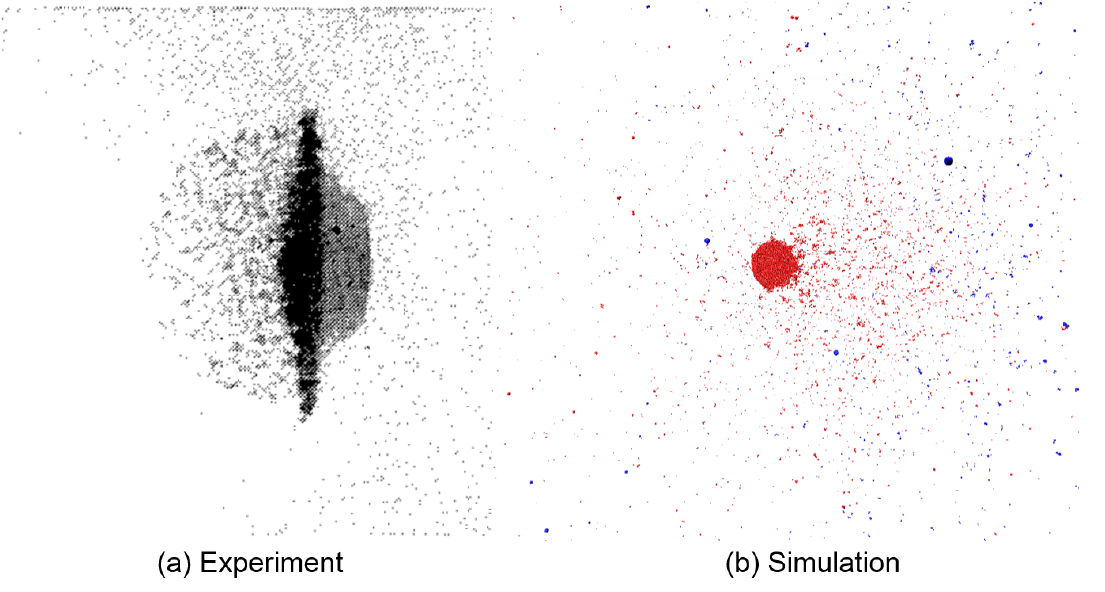
Figure 15. The shape of the debris cloud is highly affected by the t / D ratio. ( a ) High-speed radiograph of experiment; ( b ) 3D simulation shown with v 0 = 6.7 kms − 1 and t / D = 0.05. The simulation performs poorly at extremely small t / D ratios, but very well at large values, cf. Figure 14. Experimental snapshot from